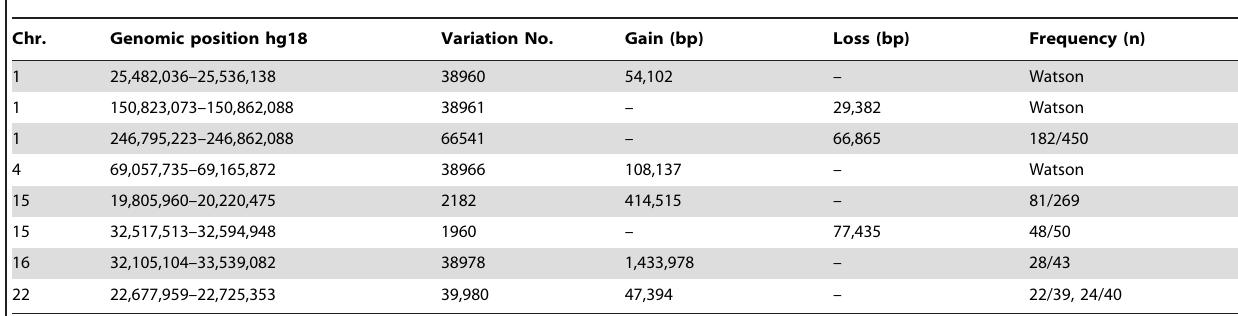
Table 2. Copy number variation (CNV) identified by array CGH in the patient.